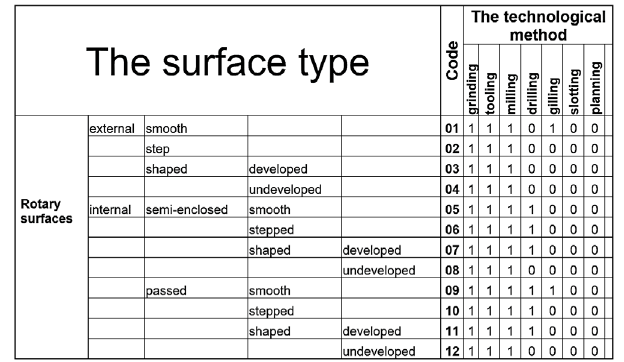
Figure 4. The example of the surface coding with the possibility of manufacturability by individual technological